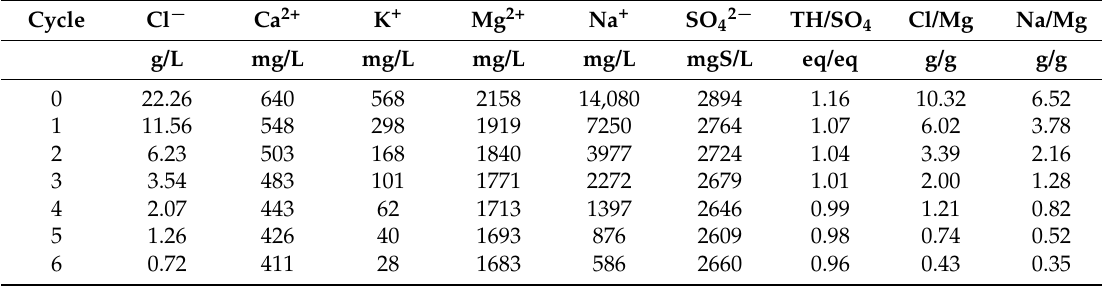
Table 5. Results of applying six DiaNF cycles (NF membrane: DLF1021) on the retentate obtained